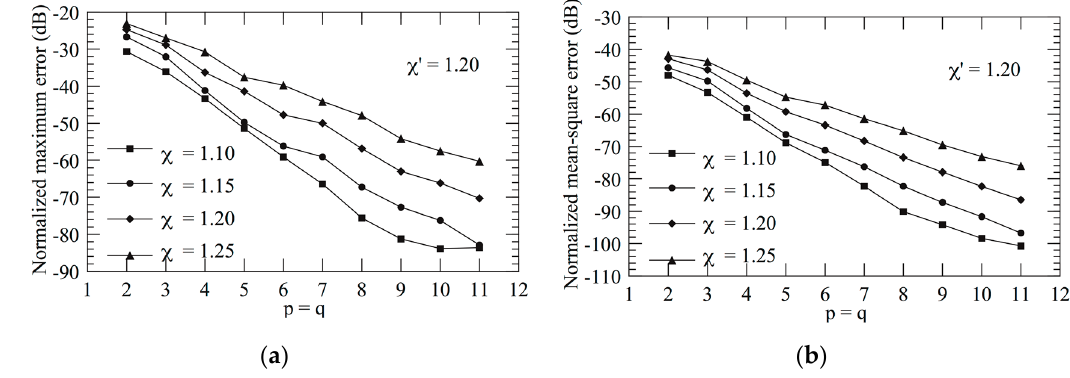
Figure 4. Errors in the reconstruction of V r : ( a ) maximum error; ( b ) mean-square error.